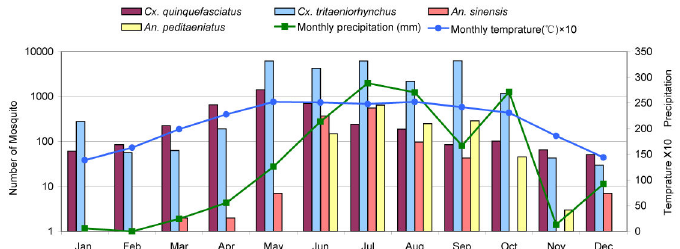
Figure 4. Monthly average temperature , total precipitation and abundance of the four predominant mosquito species collected in Ruili, 2010.